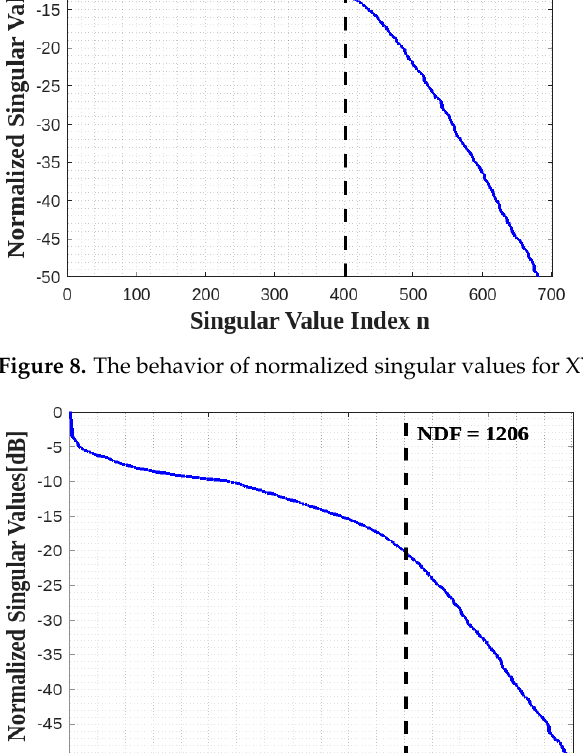
Figure 9. The behavior of normalized singular values for a cube ID.